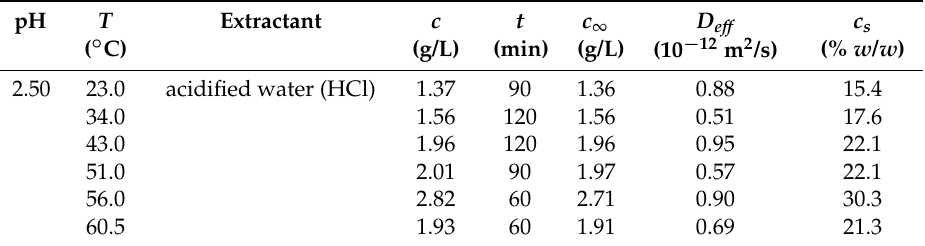
Table 3. Release data at different